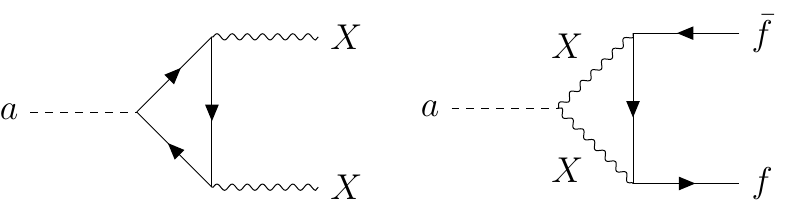
Figure 1 . On the left: ALP coupling to gauge bosons in a DFSZ-like scenario. On the right: ALP coupling to SM fermions in a KSVZ-like scenario. In both cases, X can be any pair of gauge bosons in the EW broken phase that respects SU(3) C × U(1) EM